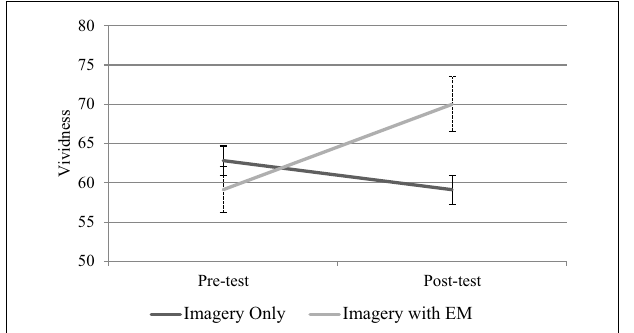
FIGURE 3 | Mean heart rate (HR) change scores with standard error bars measured in beats per minute (bpm) during imagery of fear (public speaking) script for imagery only ( n === 17) and imagery with eye movements (EM; n === 17) conditions . *Statistically significant difference between pre- and post-test change scores, p <